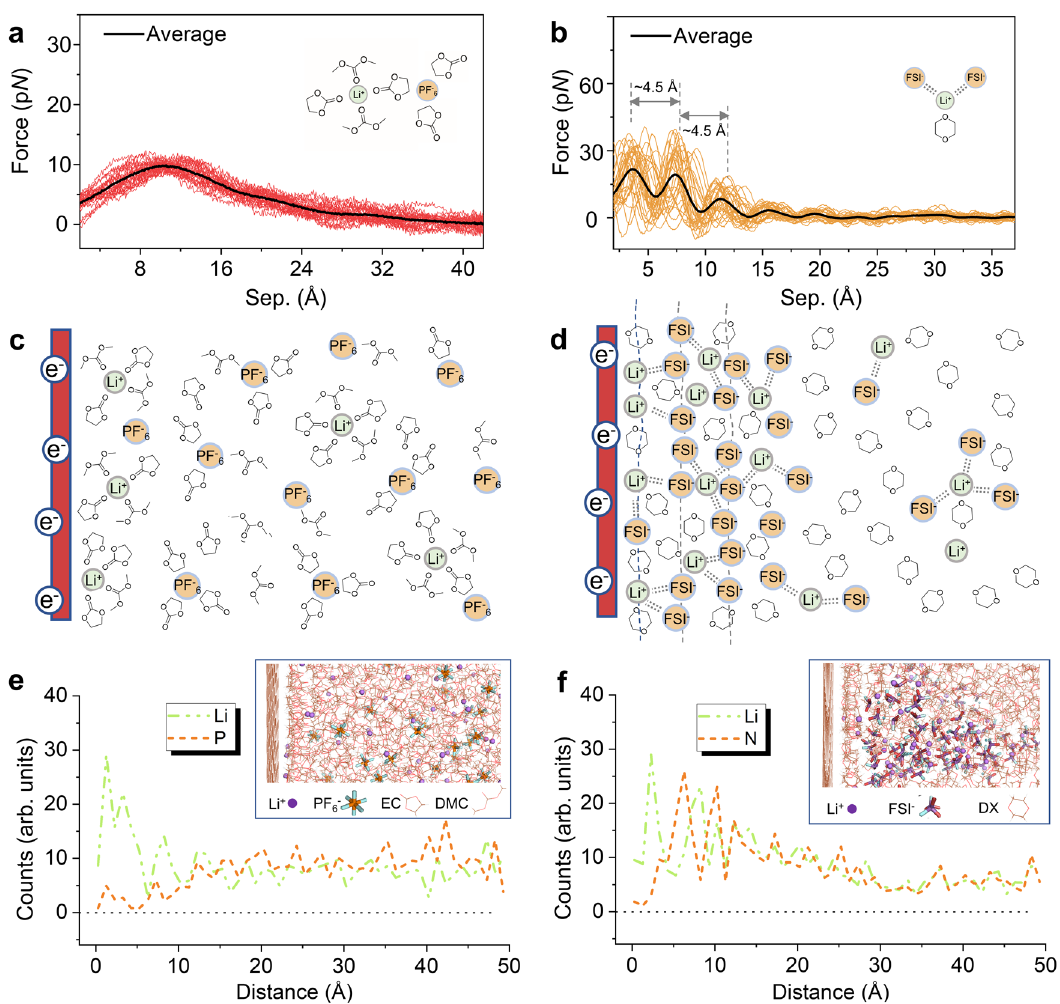
Fig. 4 | Interfacial layering structure of EDLs through AFM force-distance spectroscopy and MD simulations. Overlapped experimental force-separation (FS) curves associated with the perturbation of nanoscale EDL on graphite basal plane surface in ( a , c ) EC-based electrolyte and ( b , d ) DX-based electrolyte, respectively.Insetsin( a , b )aretheschematicEDLsolvation structureaccordingto the MD simulations. PF 6 − and FSI − in ( c , d ) represent the hexa fl uorophosphate and